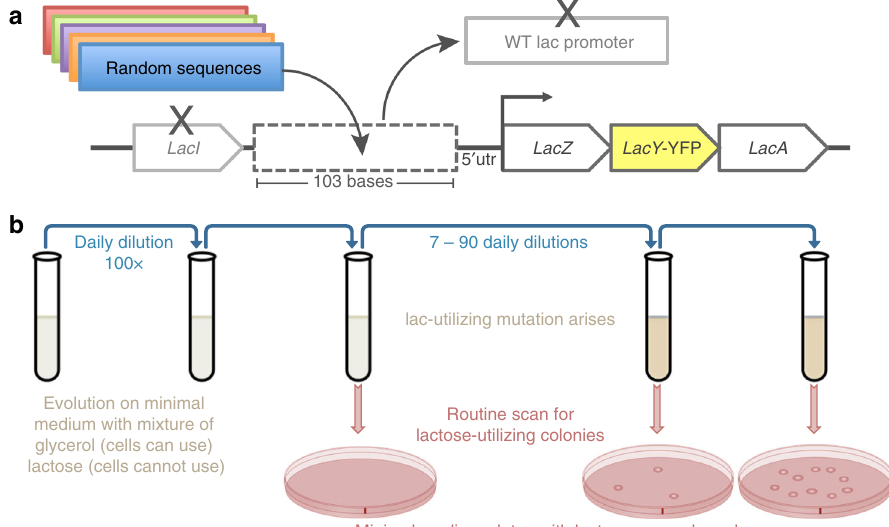
Fig. 1 Experimental setup for evolving promoters from random sequences. a We modi fi ed the chromosomal copy of the lac operon by replacing the intergenic region that harbors the WT lac promoter with a random sequence of the same length (103 bases) that abolished the cells ’ ability to utilize lactose. In addition, the lacY was tagged with YFP and the lac repressor ( lacI ) was deleted. b Cells were evolved by serial dilution in minimal medium containing both glycerol (0.05%), which the cells can utilize, and lactose (0.2%), which the cells cannot utilize unless they evolve de novo expression of the lac genes. During evolution, samples were routinely plated on minimal medium plates with lactose as a sole carbon source, for the isolation of lactose-utilizing